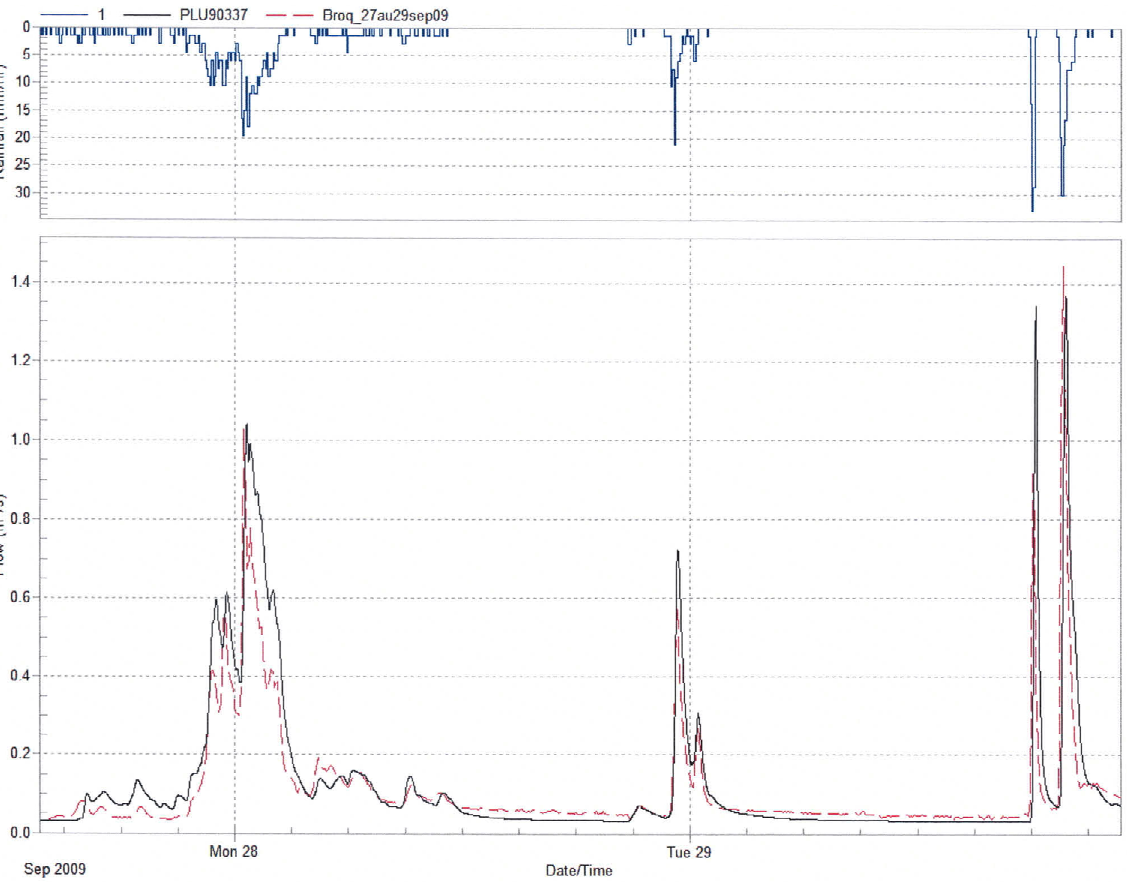
Figure 5. Example of calibration results at the Broqueville measuring point (black line = measured flow rate; red dashed line = simulated flow rate) (taken from